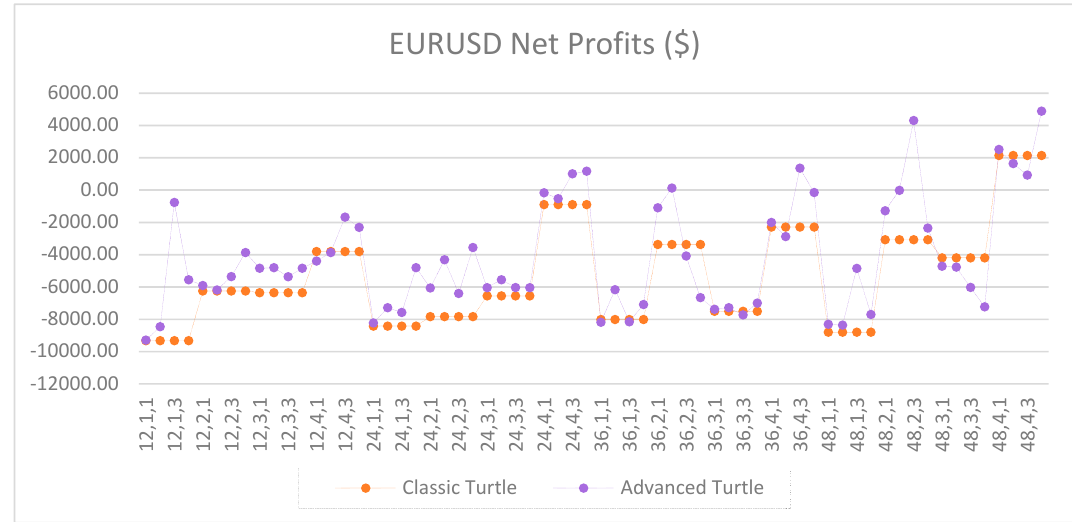
Figure A3. Net profits of EURUSD between the classic and the advanced Turtle systems for every combination of N, X, Y for the fast parameters (20, 40).